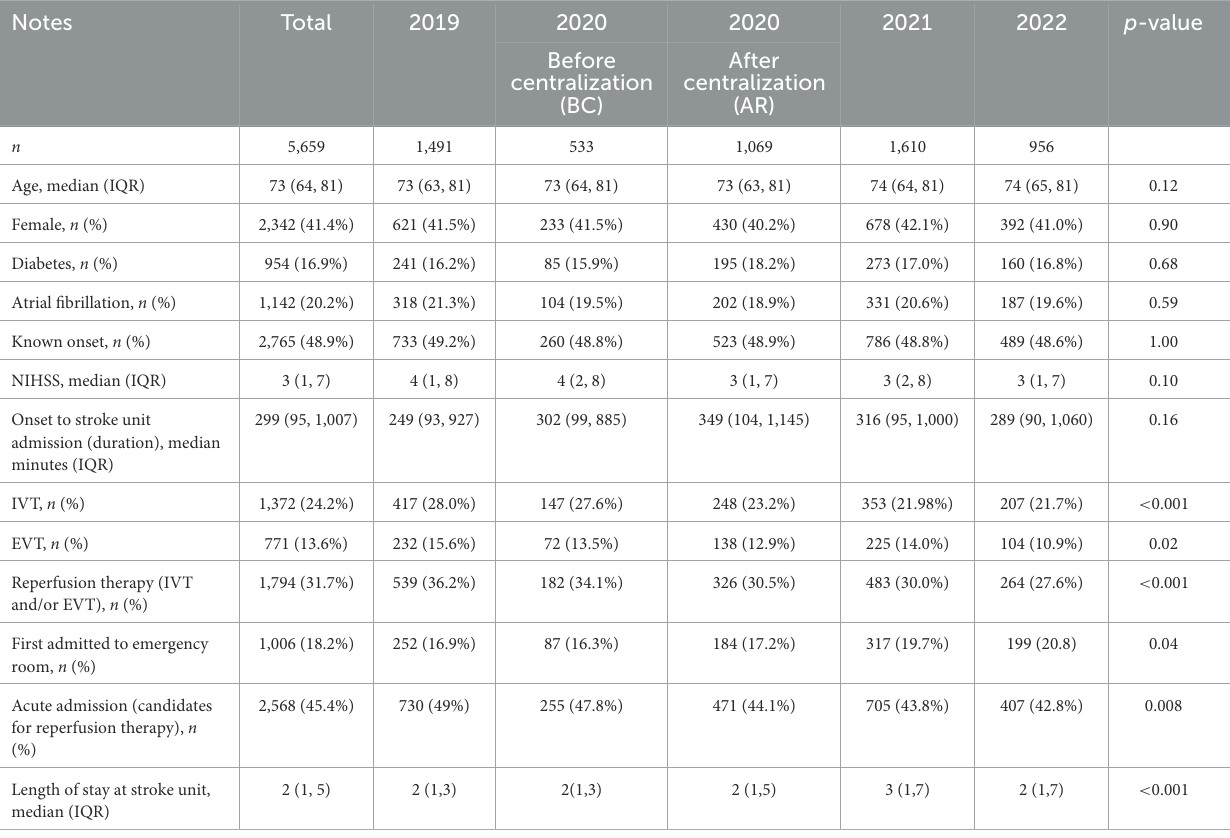
TABLE 1 Characteristics of AIS admissions during the study